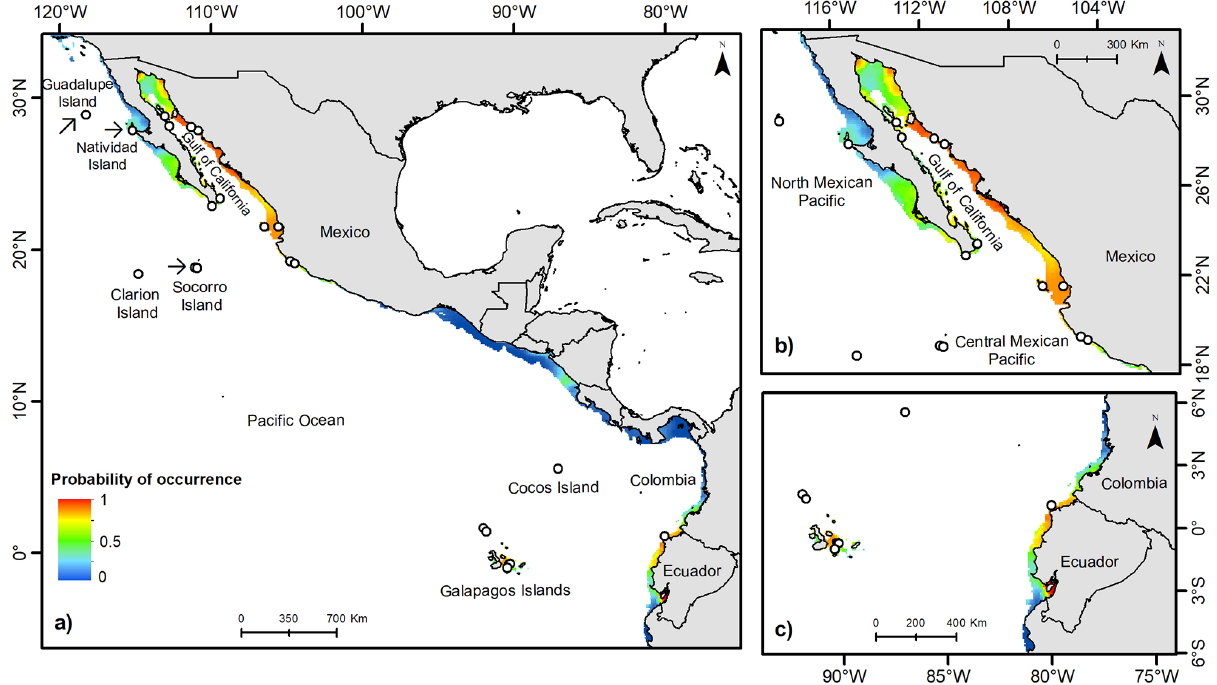
Figure 2. Georeferenced occurrences of Scyllarides astori in the Eastern Tropical Pacific (white dots) and potential distribution areas resulting from the MaxEnt model. Colors show the probability of occurrence of the species, where blue colors indicate a low probability of occurrence, and green, yellow, and red colors show a high probability of occurrence. Arrows indicate the location of the new georeferenced occurrence described in the text (Guadalupe Island, Natividad Island, and Socorro Island). The resulting potential distribution areas are shown in the complete geographic distribution range of S. astori ( a ), as well as in those areas with a high probability of occurrence (northern and Central Mexican Pacific ( b), and Colombia, Ecuador and Galapagos Islands ( c